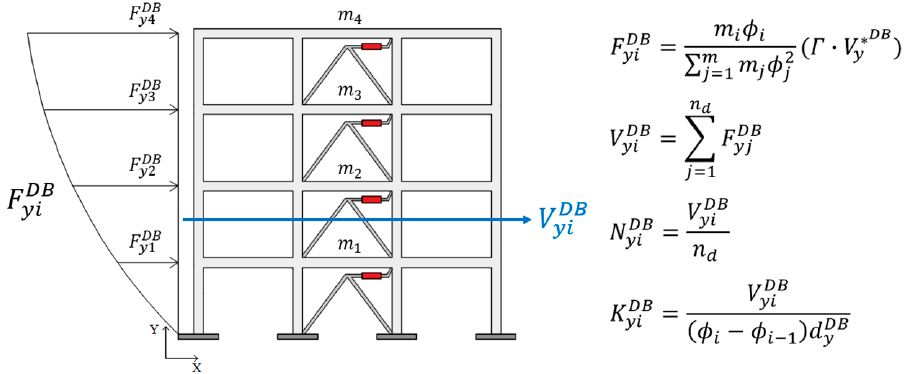
Figure 9. Graphical representation of the procedure for distributing the properties of the damped braces at the stories of the frame.